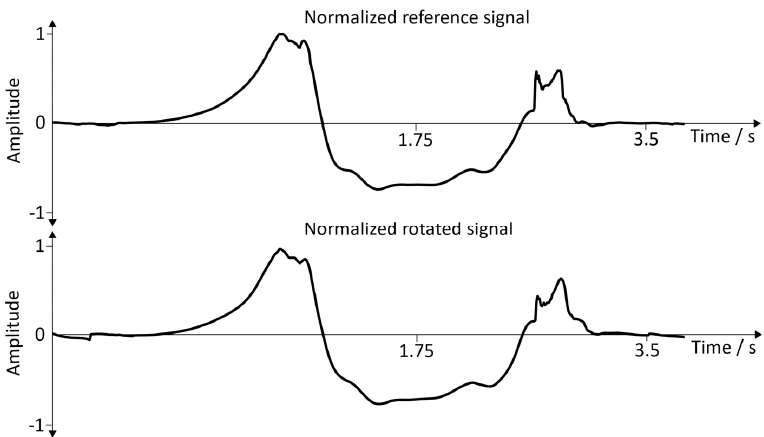
Figure 19. Normalized reference signal and normalized rotated signal. Position of the sensor: inside of the foot .